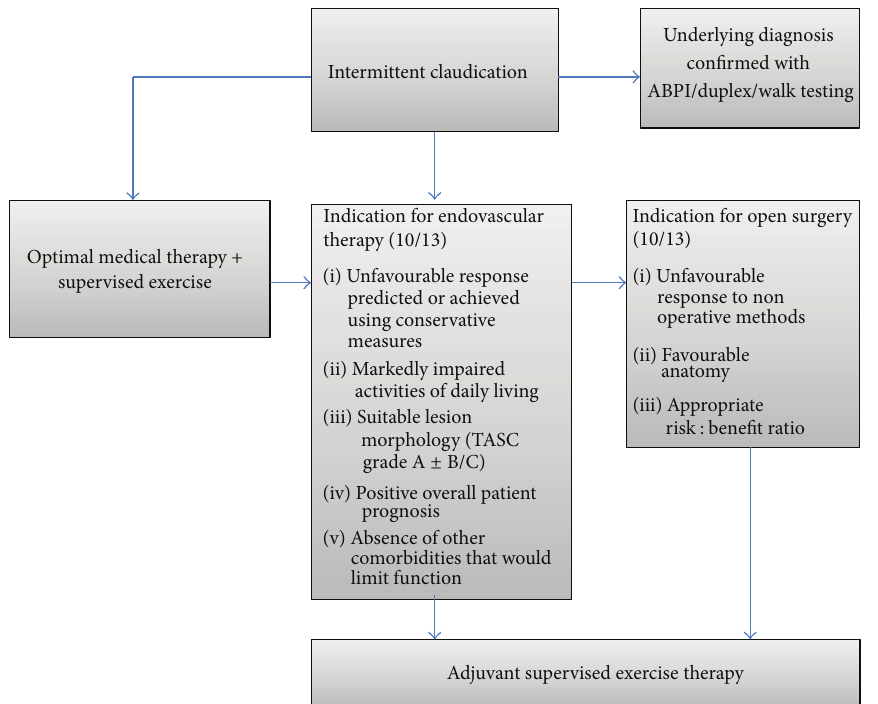
Figure 2: Management of intermittent claudication incorporating supervised exercise